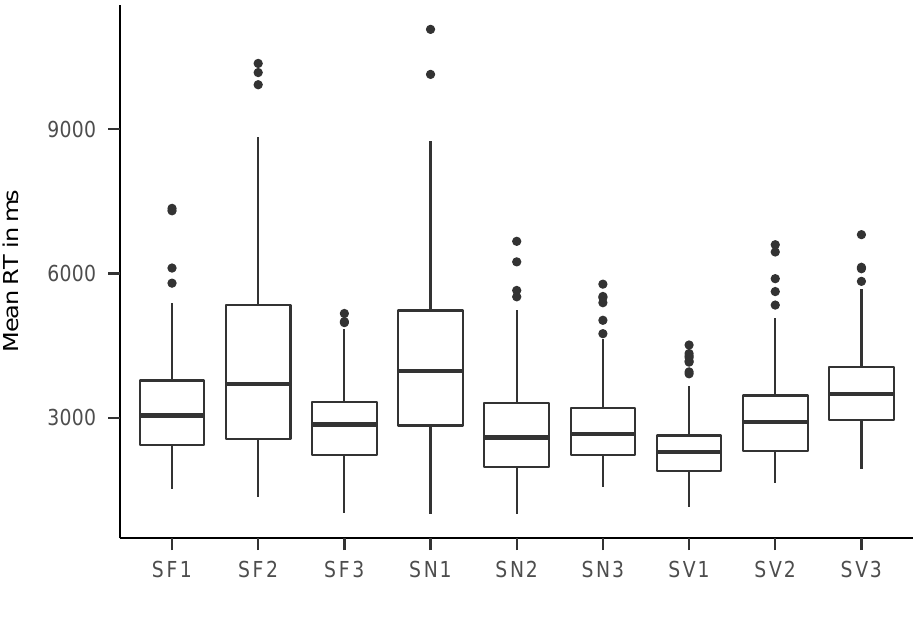
Figure 6. Boxplots of mean response times for all slow tasks. See Table 1 for an explanation of the task